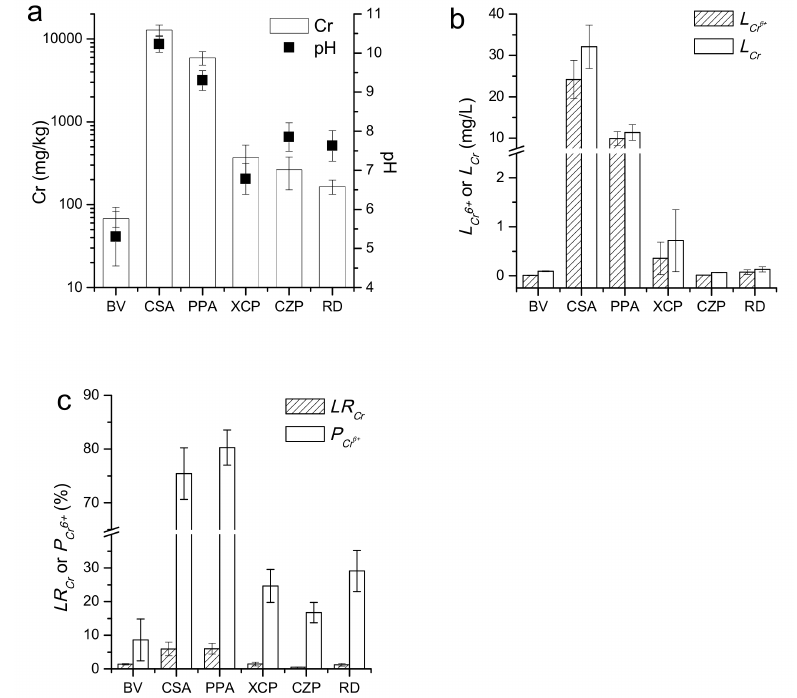
Figure 2. The Cr concentration and pH ( a ), L Cr and L Cr 6+ ( b ), LR Cr and P Cr6+ ( c ) of the surface soils. BV: Background Values; CSA: COPR Storage Area; PPA: Production Plant Area; XCP: Xiangyue Chemical Plant; CZP: Changsha Zinc Plant; RD: residential district.